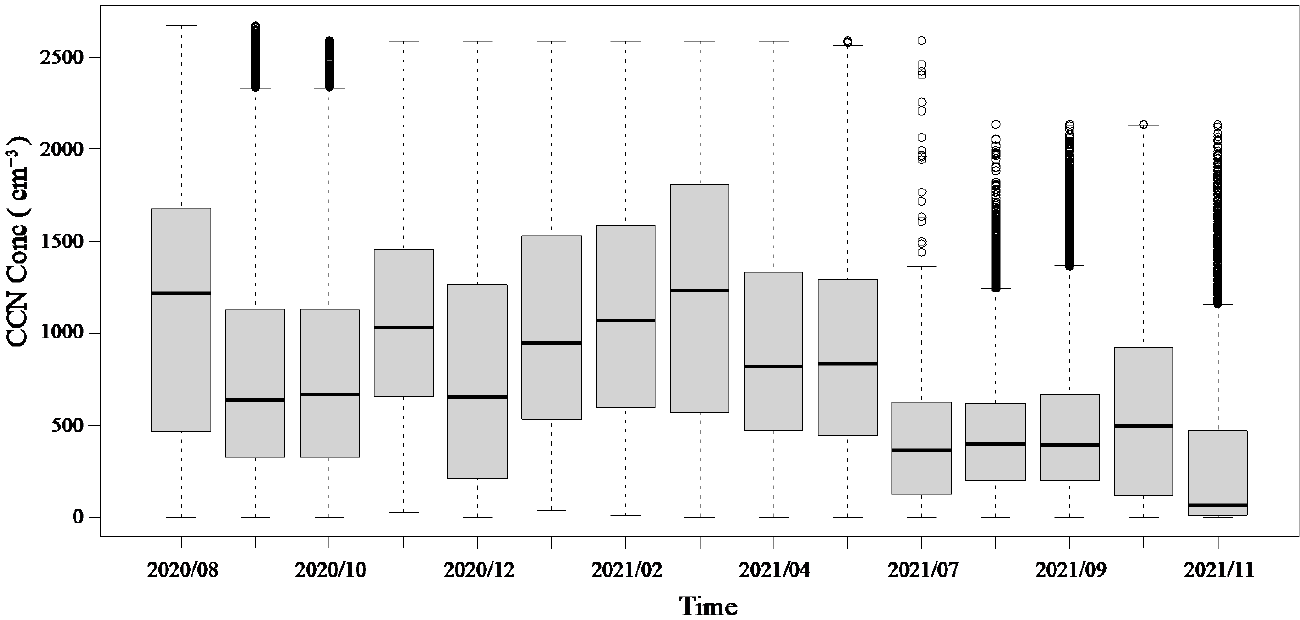
Figure 2. The monthly concentration of CCN in LPS from August 2020 to November 2021.